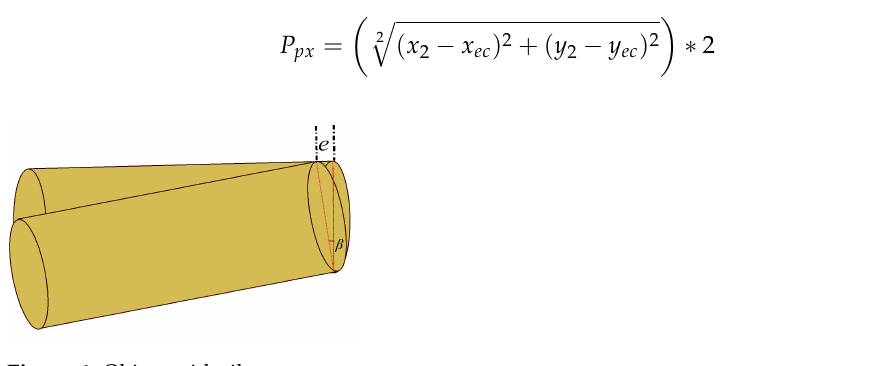
Figure 4. Object with tilt error e